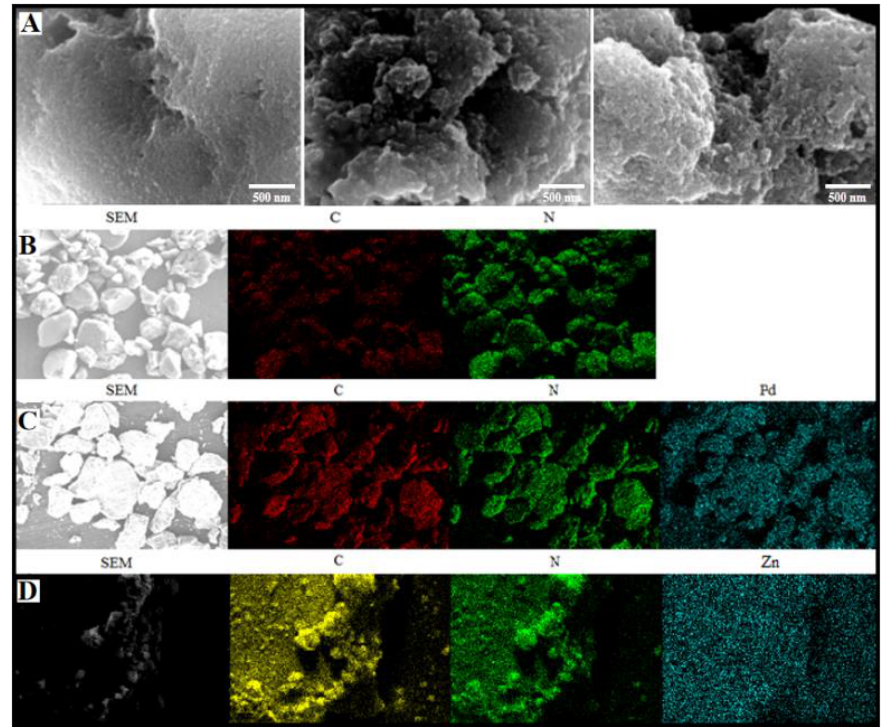
Figure 2. ( A ) TEM of THPP-TiO 2 , THPP-Pd-TiO 2 , and THPP-Zn-TiO 2 , and the elemental mappings image of ( B ) THPP-TiO 2 , ( C ) THPP-Pd-TiO 2 and ( D ) THPP-Zn-TiO 2 .